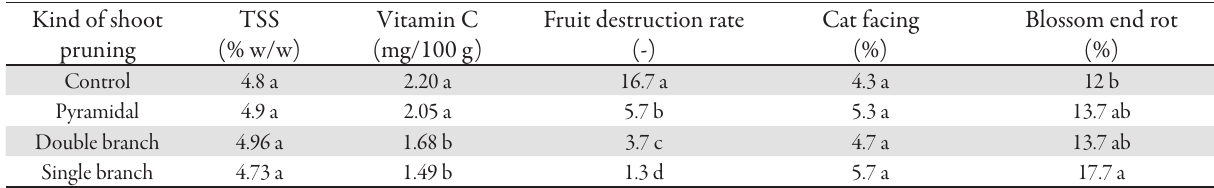
Tab. 2. Effect of shoot pruning on quality of Semi-determinate tomato in greenhouse Kind of shoot